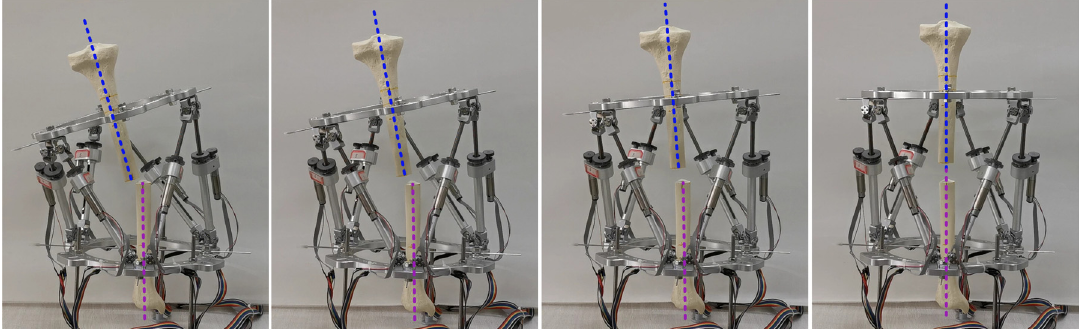
Figure 9. The graphical stages of deformity correction with sequential adjustment.